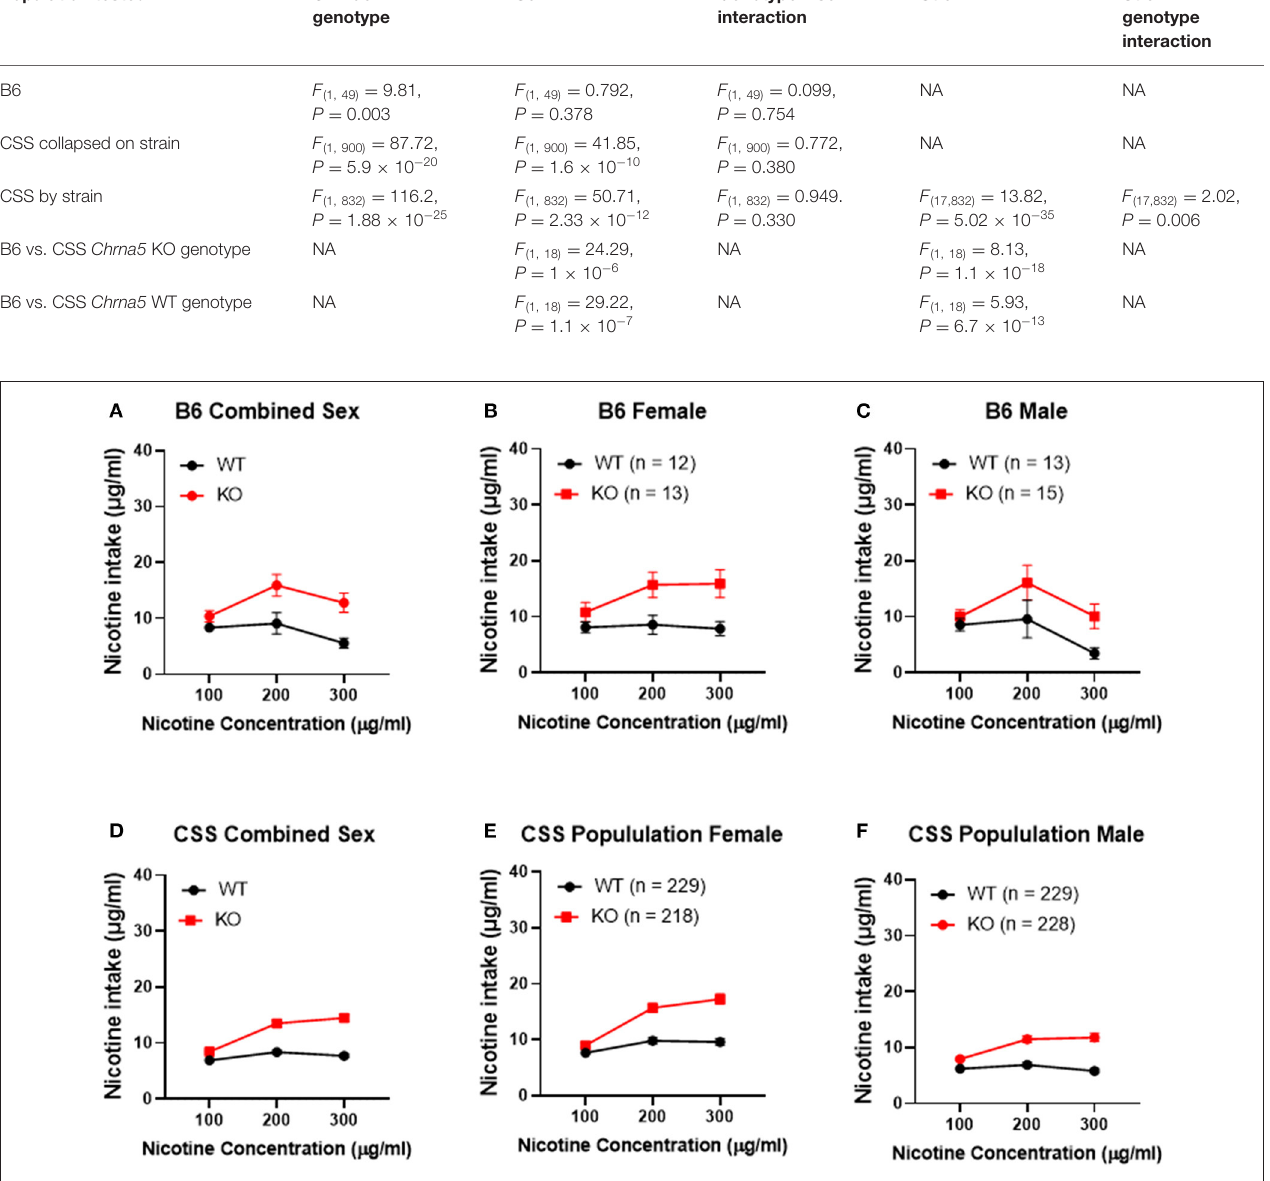
FIGURE 2 | Effect of Chrna5 genotype on nicotine consumption in B6 and chromosome substitution strain (CSS) mice. Deletion of Chrna5 leads to increased nicotine consumption in B6 background mice ( P = 0.003). Although no main effect of sex was observed in B6 mice, combined sex (A) as well as data for each sex [female (B) and male (C) ] are shown for comparison. For the entire population of CSS mice, there is a main effect of Chrna5 genotype as well as a main effect of sex. The impact of Chrna5 genotype collapsed on sex (D) and in female CSS (E) ( P = 1.76 × 10 − 10 ) and male CSS (F) ( P = 3.43 × 10 − 11 ) is shown. Data represent mean ± SEM.